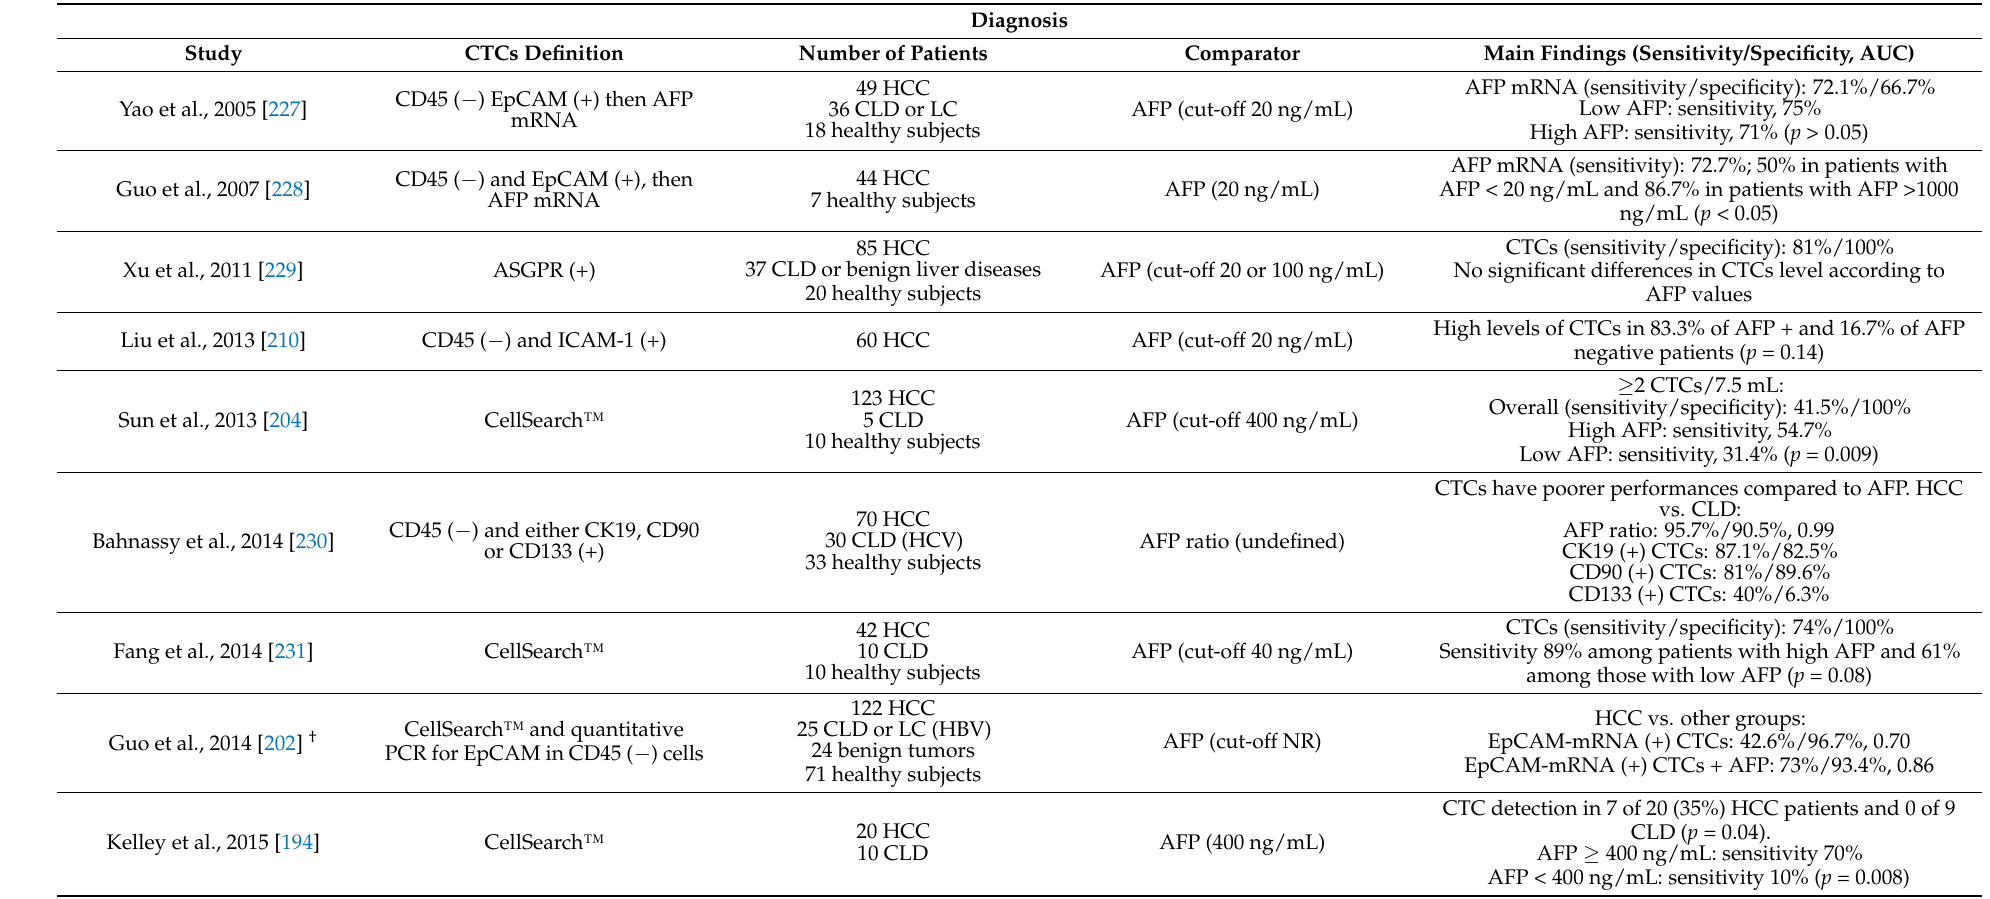
Table 3. Studies on use of circulating tumor cells (CTCs) as biomarkers in HCC